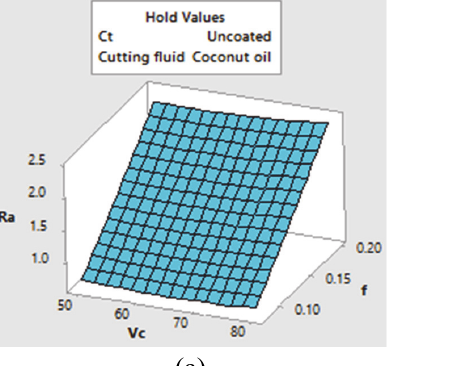
Fig. 7. Surface plot of Ra in MQL enivironment (Palm oil ) (a) Unoated (b) PVD TiAlN insert